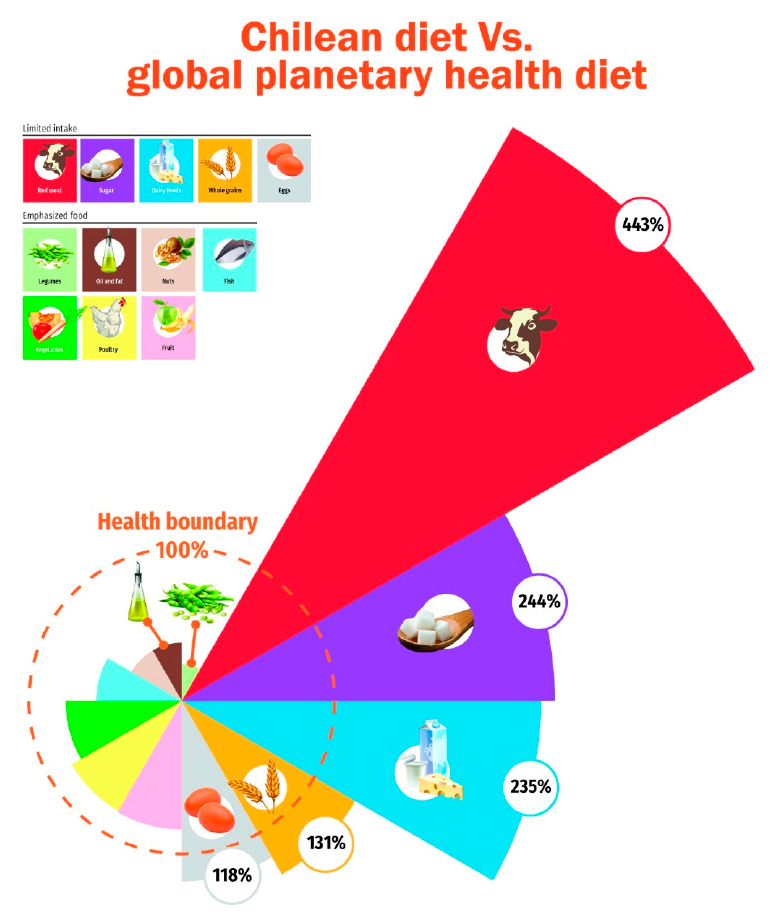
Figure 3. The “diet gap” between current Chilean dietary patterns and the Planetary health diet defined by EAT–Lancet Commission [4]. The Health boundary is a target defined as the safe operating space for food systems, human health, and environmental sustainability. Food groups outside this health boundary are unsustainable. Graphic credit to http://www.eatforum.org (accessed on 4 July 2022).